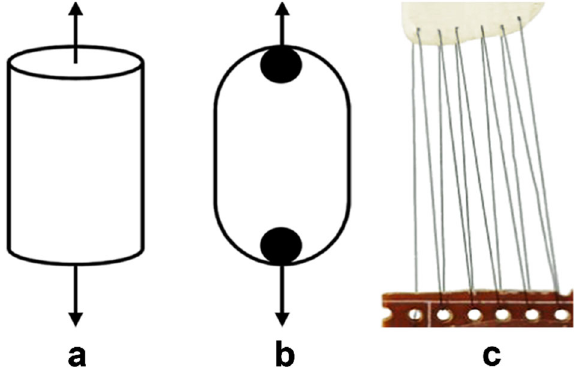
Fig. 2 Schematic diagram of testing methods for assessing mechanical properties of the vascular scaffolds: a Axial stretching. b Radial stretching. c Suture strength testing